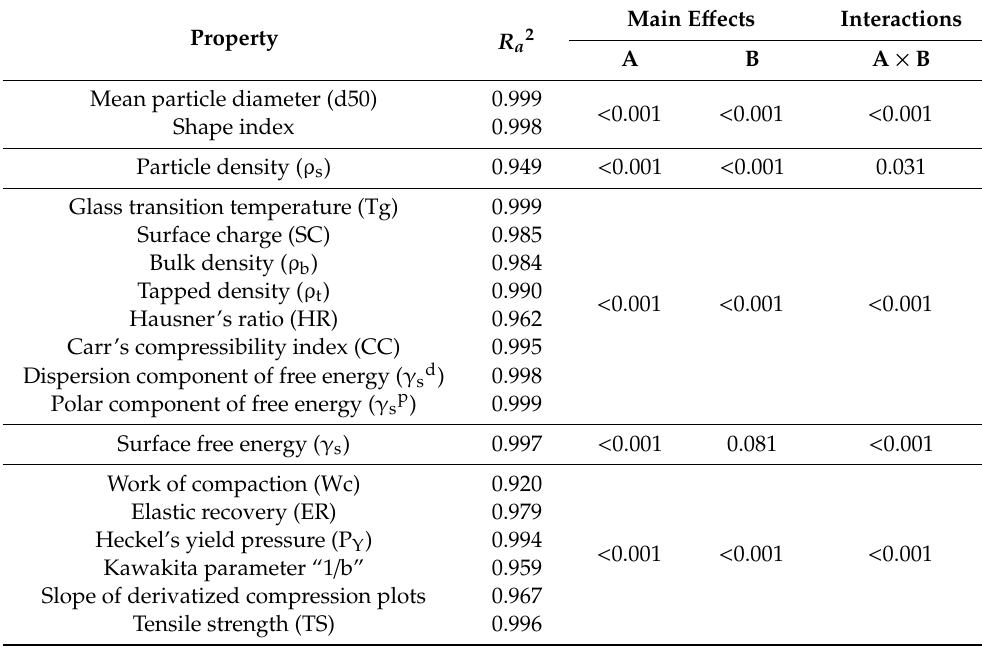
Table 3. ANOVA results (statistical significance, p-values) of main effects and interactions of the polymer (A) and treatment (hot-melt extrusion (HME)) (B) on the properties of experimental